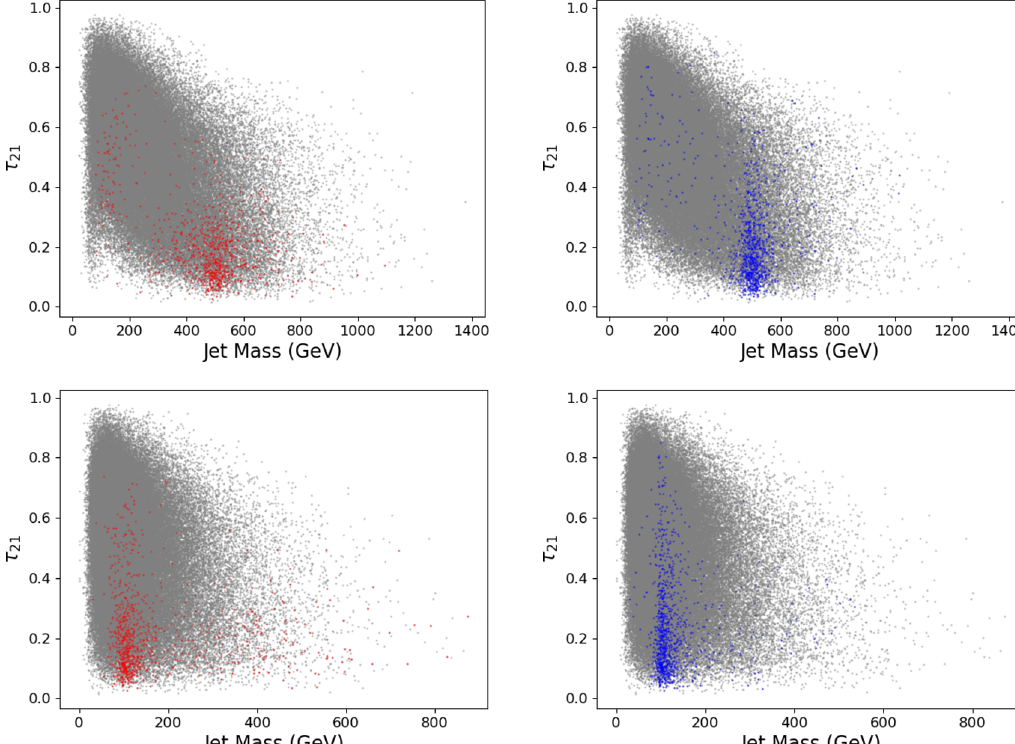
Figure 6 . Correlation between τ 21 and jet mass for the dataset with 1% signal. The top row corresponds to the heavier jet and the bottom row the lighter jet. On the left (in red) are the 1% of events the TNT classifier found to be most signal-like and on the right (in blue) the true signal